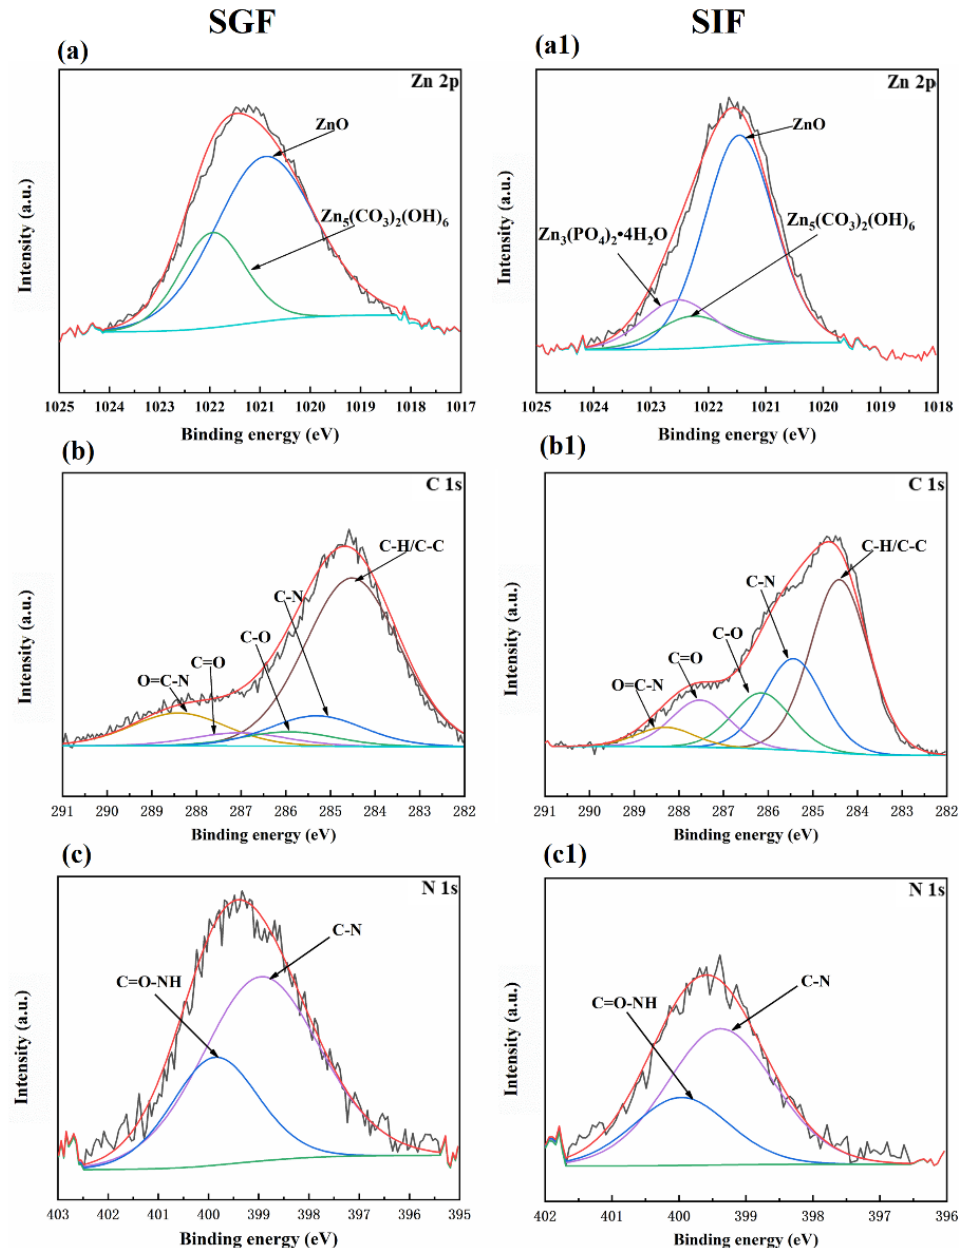
Figure 5. XPS spectrum of the samples immersed in SGF and SIF for 7 days. ( a – c ) Zn–0.4Li alloy in SGF; ( a1 – c1 ) in SIF. ( a , a1 ) Zn 2p, ( b , b1 ) C 1s and ( c , c1 ) N